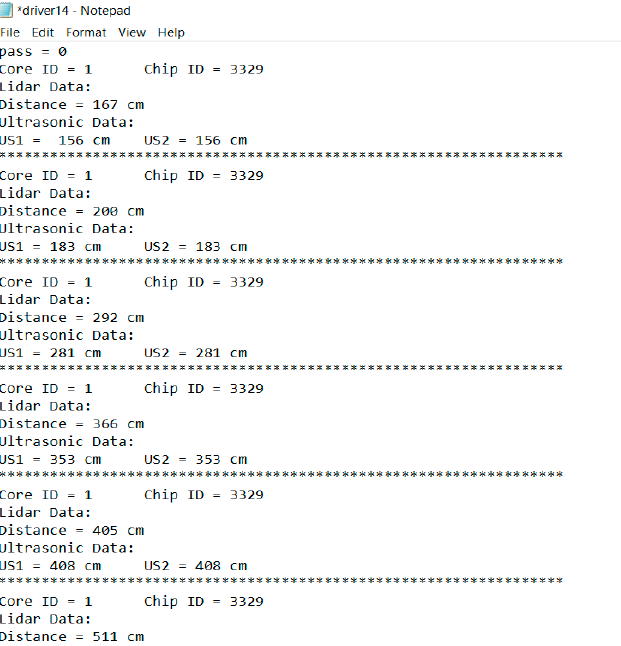
Figure 4. Sample of distance data recorded by FPGA in text format.